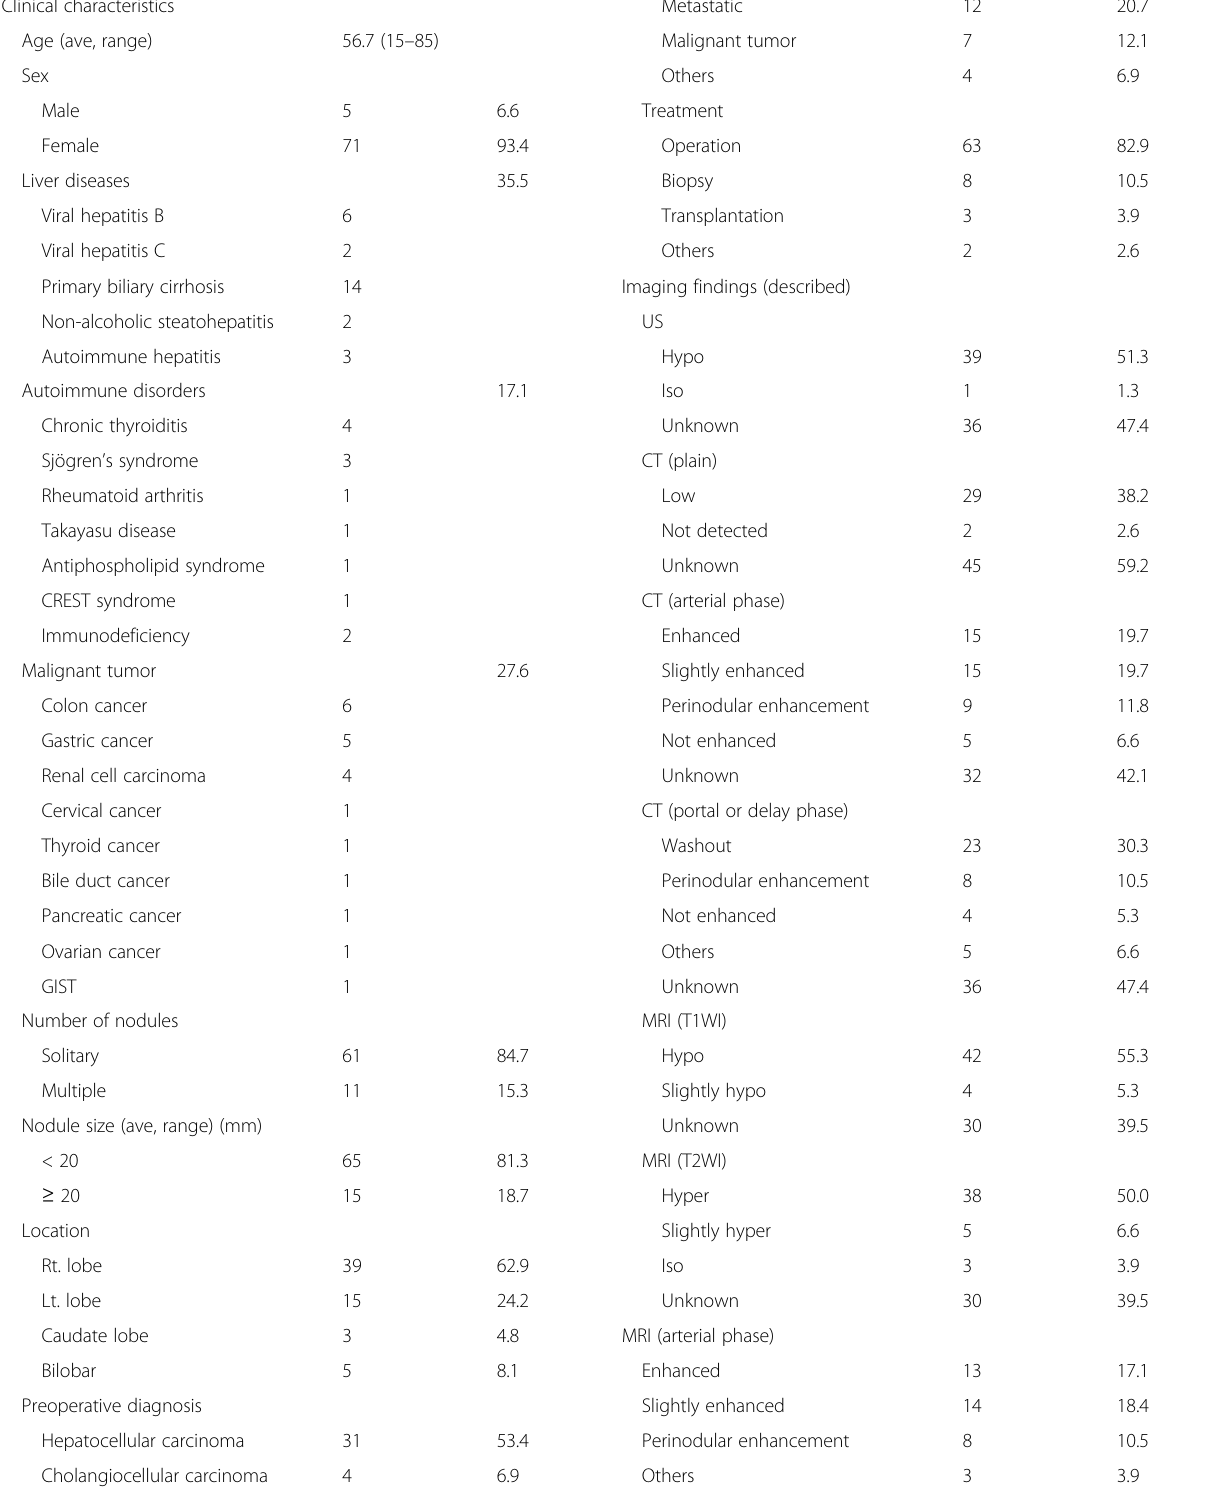
Table 1 Clinicopathological features of reactive lymphoid hyperplasia of the liver